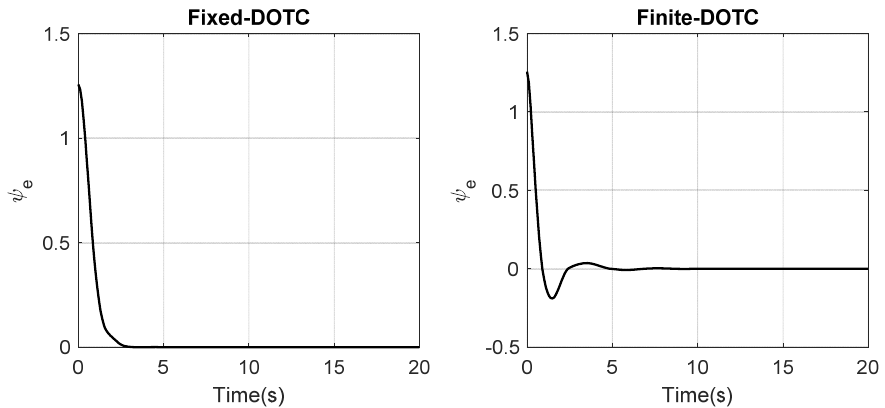
Figure 15. The orientation tracking error in part 3.